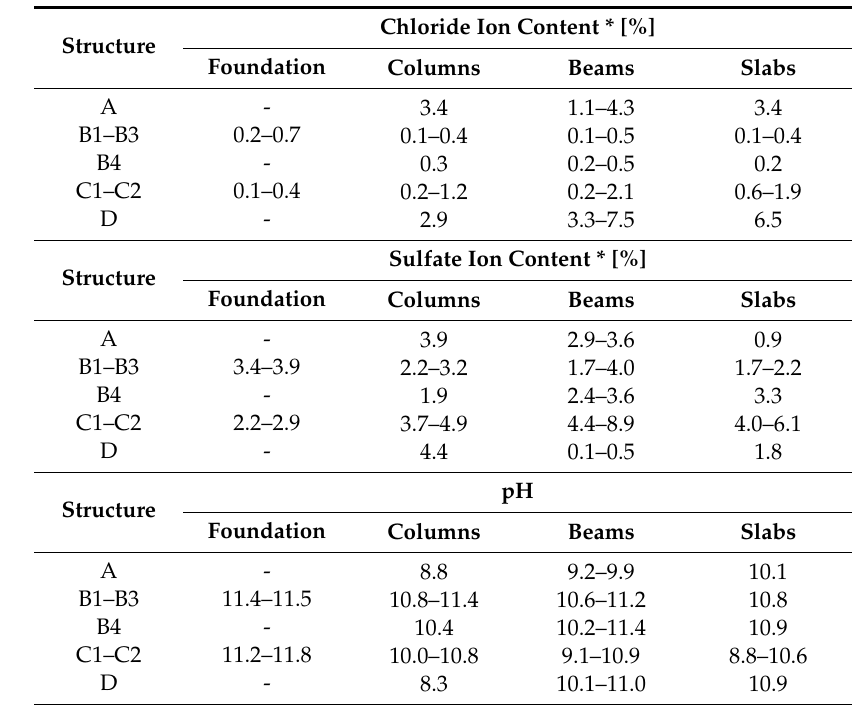
Table 3. Results of chemical tests.